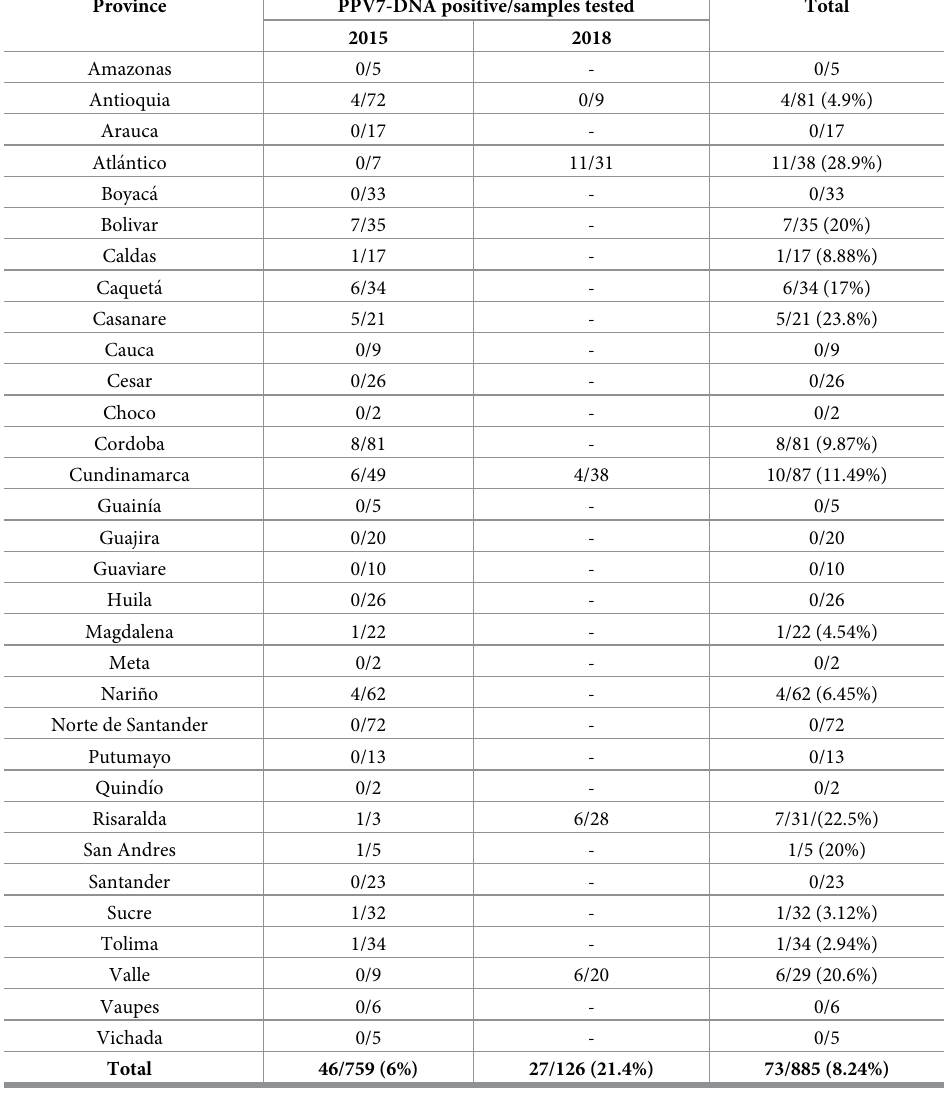
Table 1. Detection of PPV7-DNA in commercial farms. By 2015 in the 32 provinces that make up Colombia from stool and by 2018 in five provinces from serum. Province PPV7-DNA positive/samples